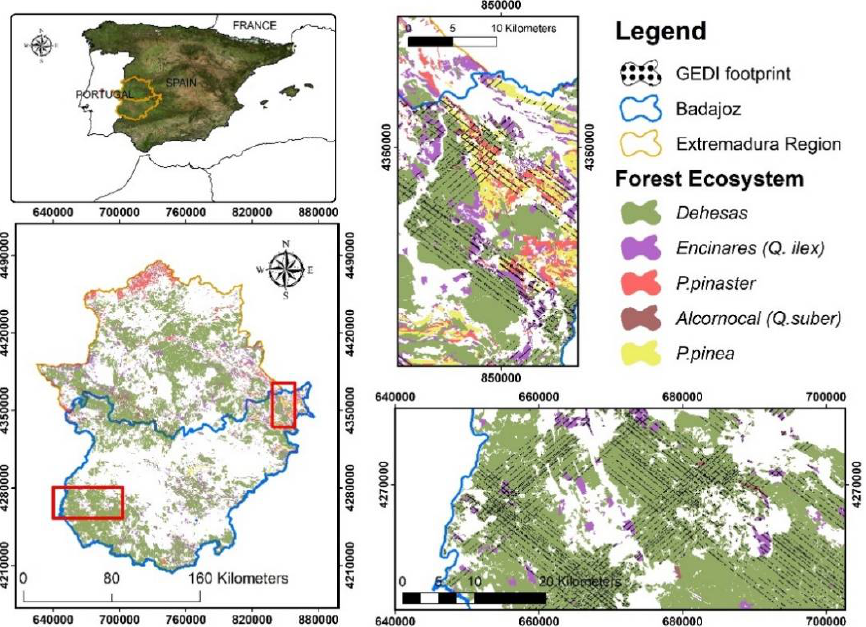
Figure 1. Boundary of the ‘Badajoz Province’ forest study site (blue line) and the locations of GEDI shots inside the different Mediterranean forest types. The red rectangles zooms represent the distribution of GEDI orbital tracks across the different Forest Ecosystems.